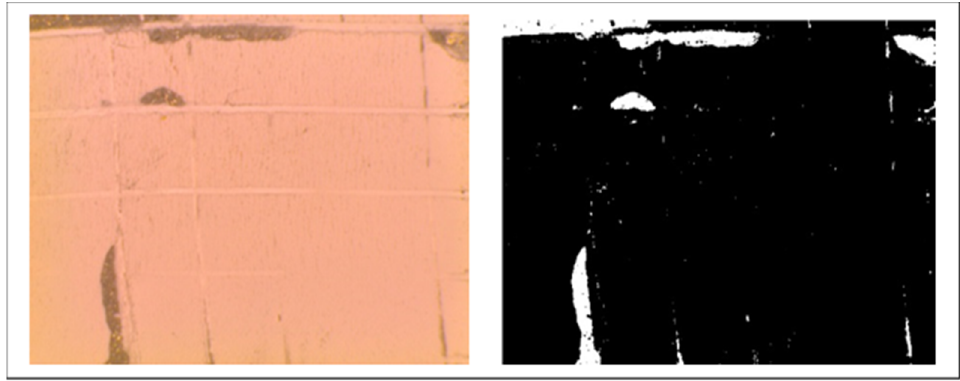
Figure A1. Image analysis example for the composite with polymer derived ceramics after crosscut test.